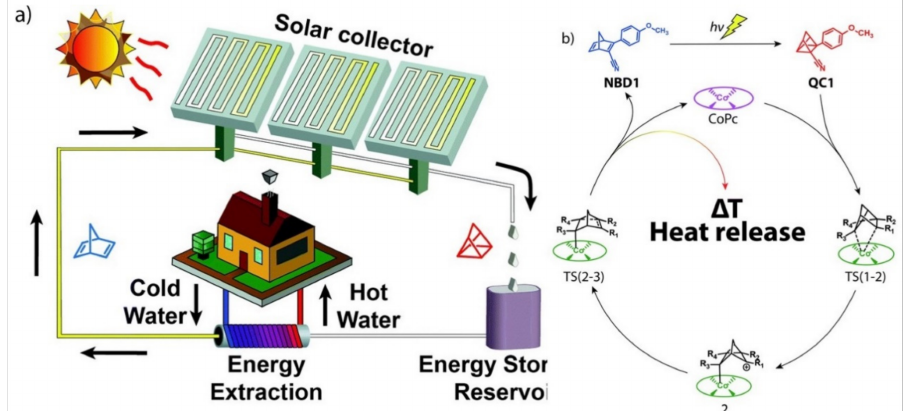
Figure 10. ( a ) Operating set up based on the MOST concept; ( b ) Catalytic cycle for the back-reaction. Adapted with permission from ref [130]. Copyright 2019 The Royal Society of